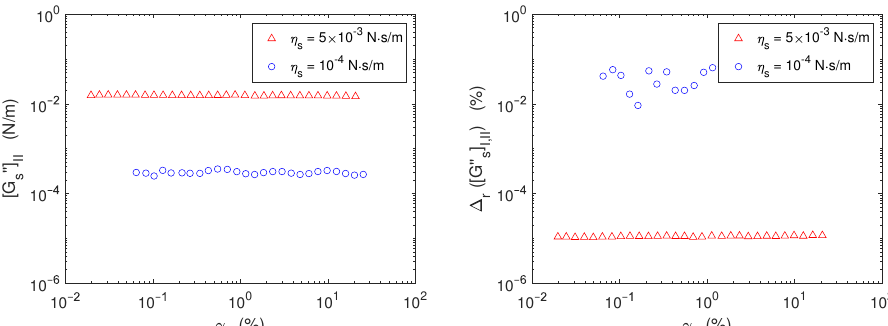
Figure 12. Left panel: Interfacial loss modulus, [ G (cid:48)(cid:48) s ] II as a function of strain, γ , for the silicone oil films with η s = 5 × 10 − 3 N · s/m (red triangles) and η s = 10 − 4 N · s/m (blue circles). Right panel: Relative difference, ∆ r ([ G (cid:48)(cid:48) s ] I , II ) , between the loss modulus of the thin films of silicone oil obtained with PV-I and PV-II as a function of strain.